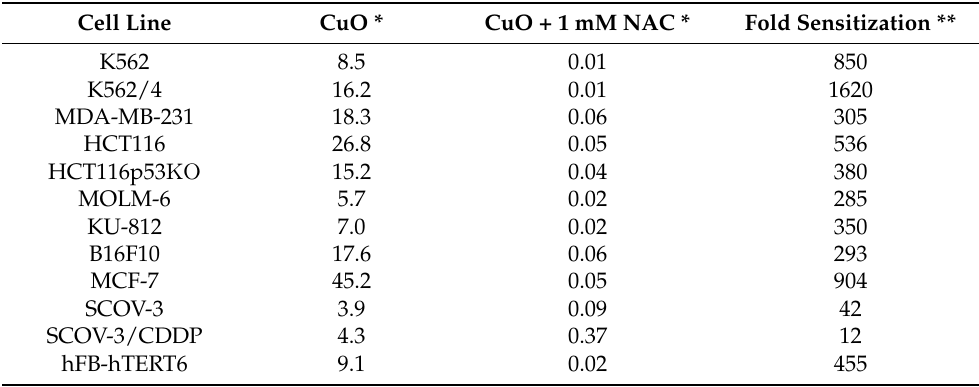
Table 1. NAC significantly enhances the cytotoxicity of CuO NPs.